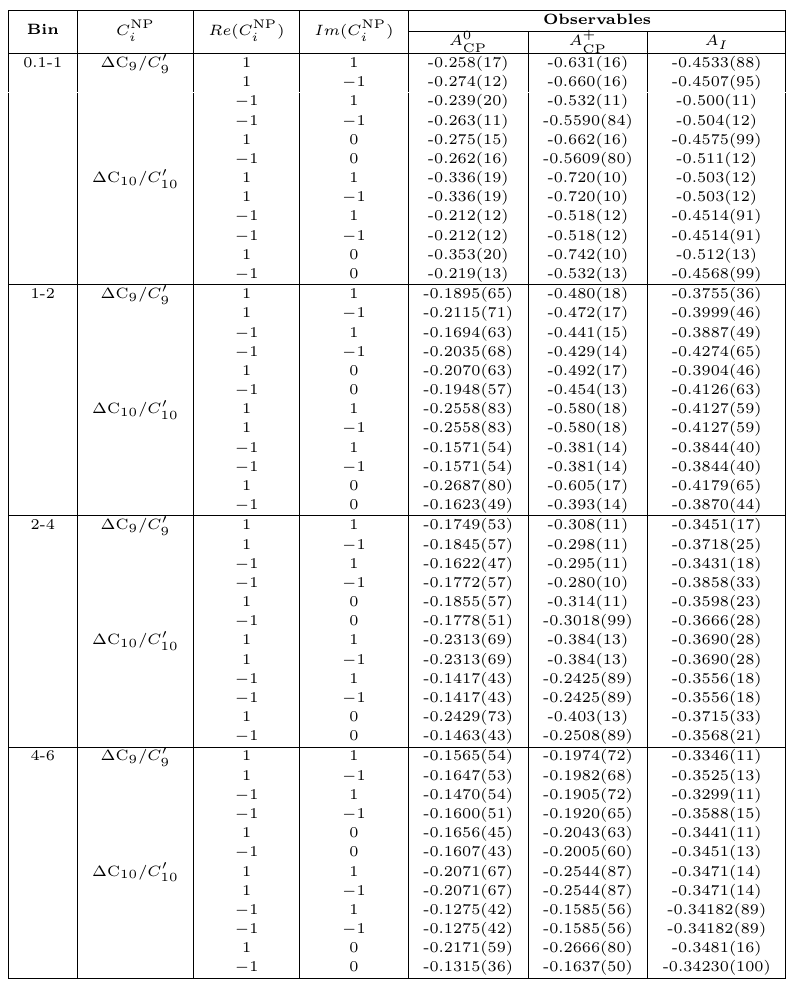
Table 18 . The dependence of the CP and Isospin asymmetry observables corresponding to B → πll on the real and imaginary parts of the NP WC’s ∆ C and C 0 for the q 2 bins 0 . 1 − 1 , 1 − 2 , 2 − 4 9 , 10 9 , 10 and 4 − 6 GeV 2 for a few benchmark values of the real and imaginary parts of the corresponding WC’s. The + , 0 superscript over A denotes the charge of the initial state B and the final state CP π